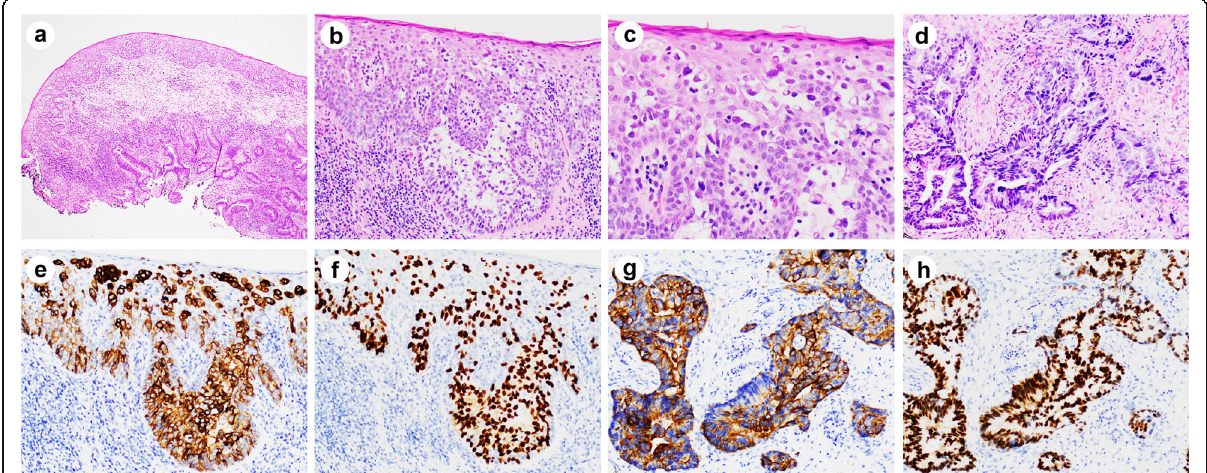
Fig. 3 Histologic and immunohistochemical features of secondary perianal Paget ’ s disease with associated invasive adenocarcinoma. a Low magnification showed intraepithelial Paget ’ s cells and underlying conventional invasive adenocarcinoma. b-d High magnification view of ( a ) showed Paget ’ s cells ( b , c ) and invasive adenocarcinoma ( d ). Paget ’ s cells are positive for CK20 ( e ) and CDX2 ( f ) by immunohistochemistry.